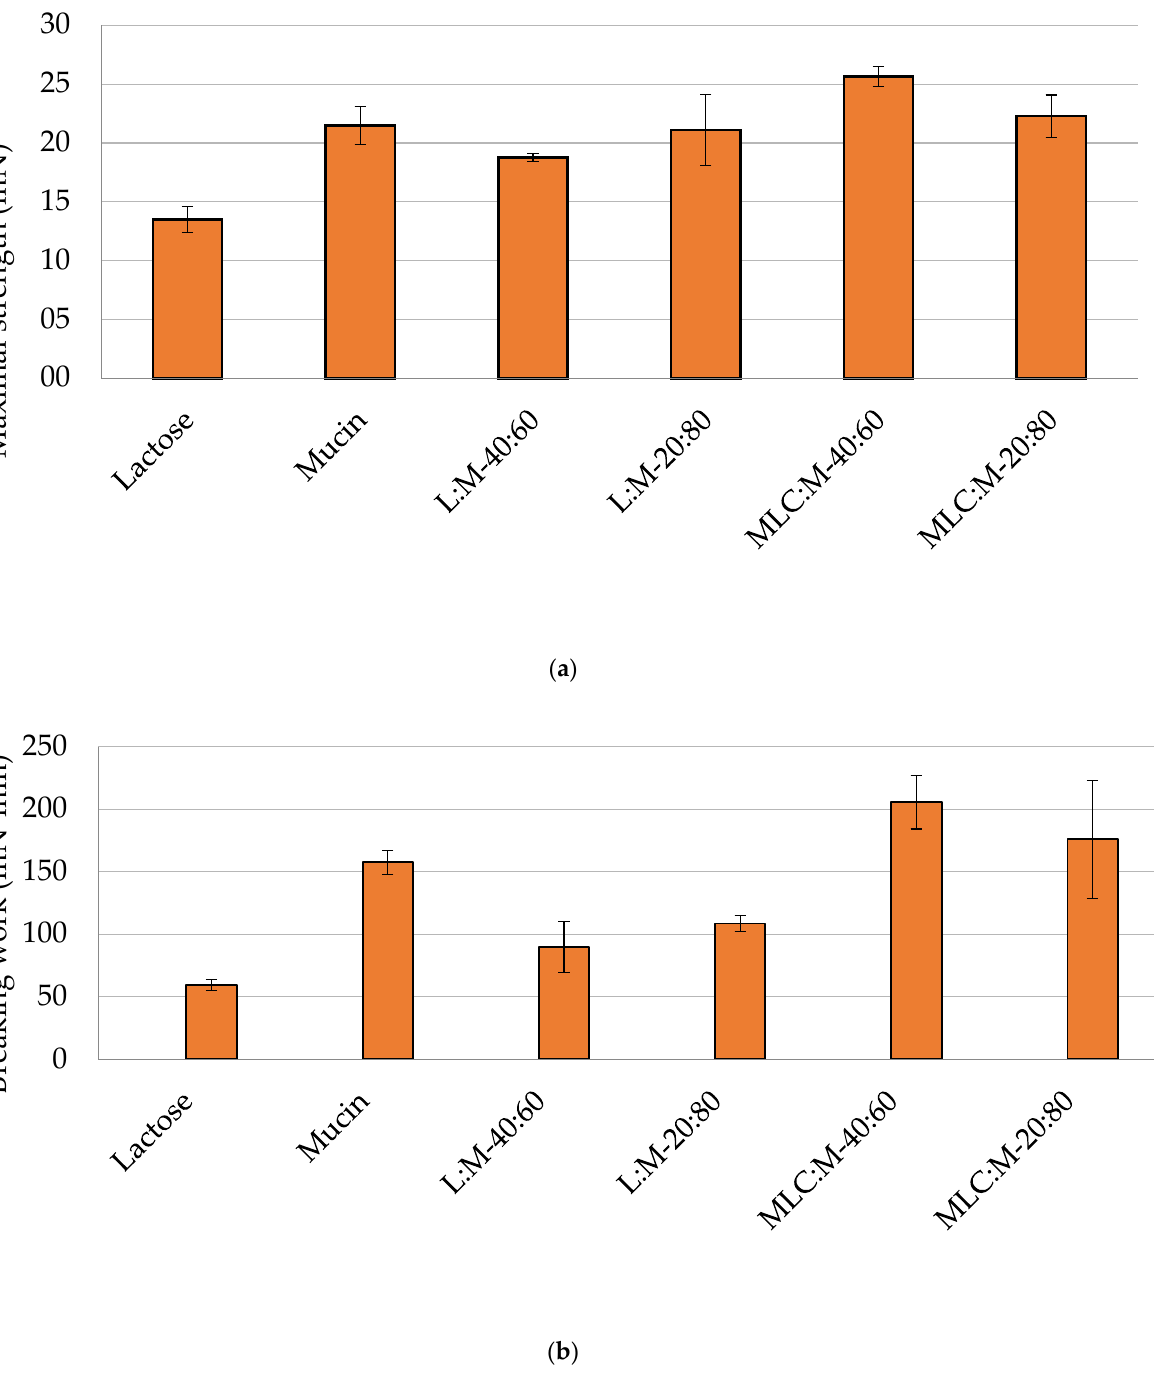
Figure 7. Maximal strength ( a ) and breaking work ( b ) of tablets made of lactose, mucin, lactose:mucin 40:60 w / w (L:M-40:60), lactose:mucin 20:80 w / w (L:M-20:80, CH-MLC:mucin 40:60 w / w (MLC:M-40:60) and CH-MLC:mucin 20:80 w / w (MLC:M-20:80).